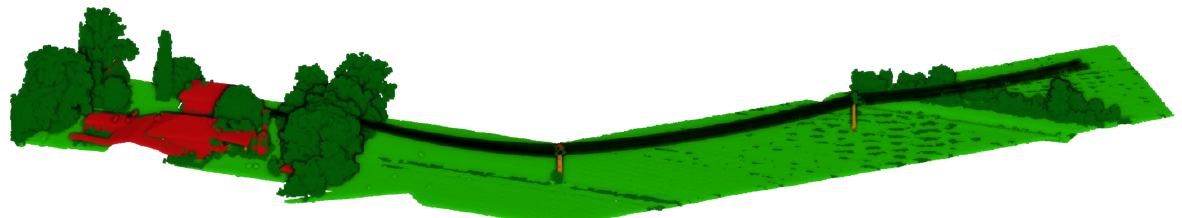
Figure 1. A LiDAR point cloud classified with our approach in 5 classes: buildings (red), powerline poles (orange), powerline cables (black), ground/soil (light green) and trees (dark